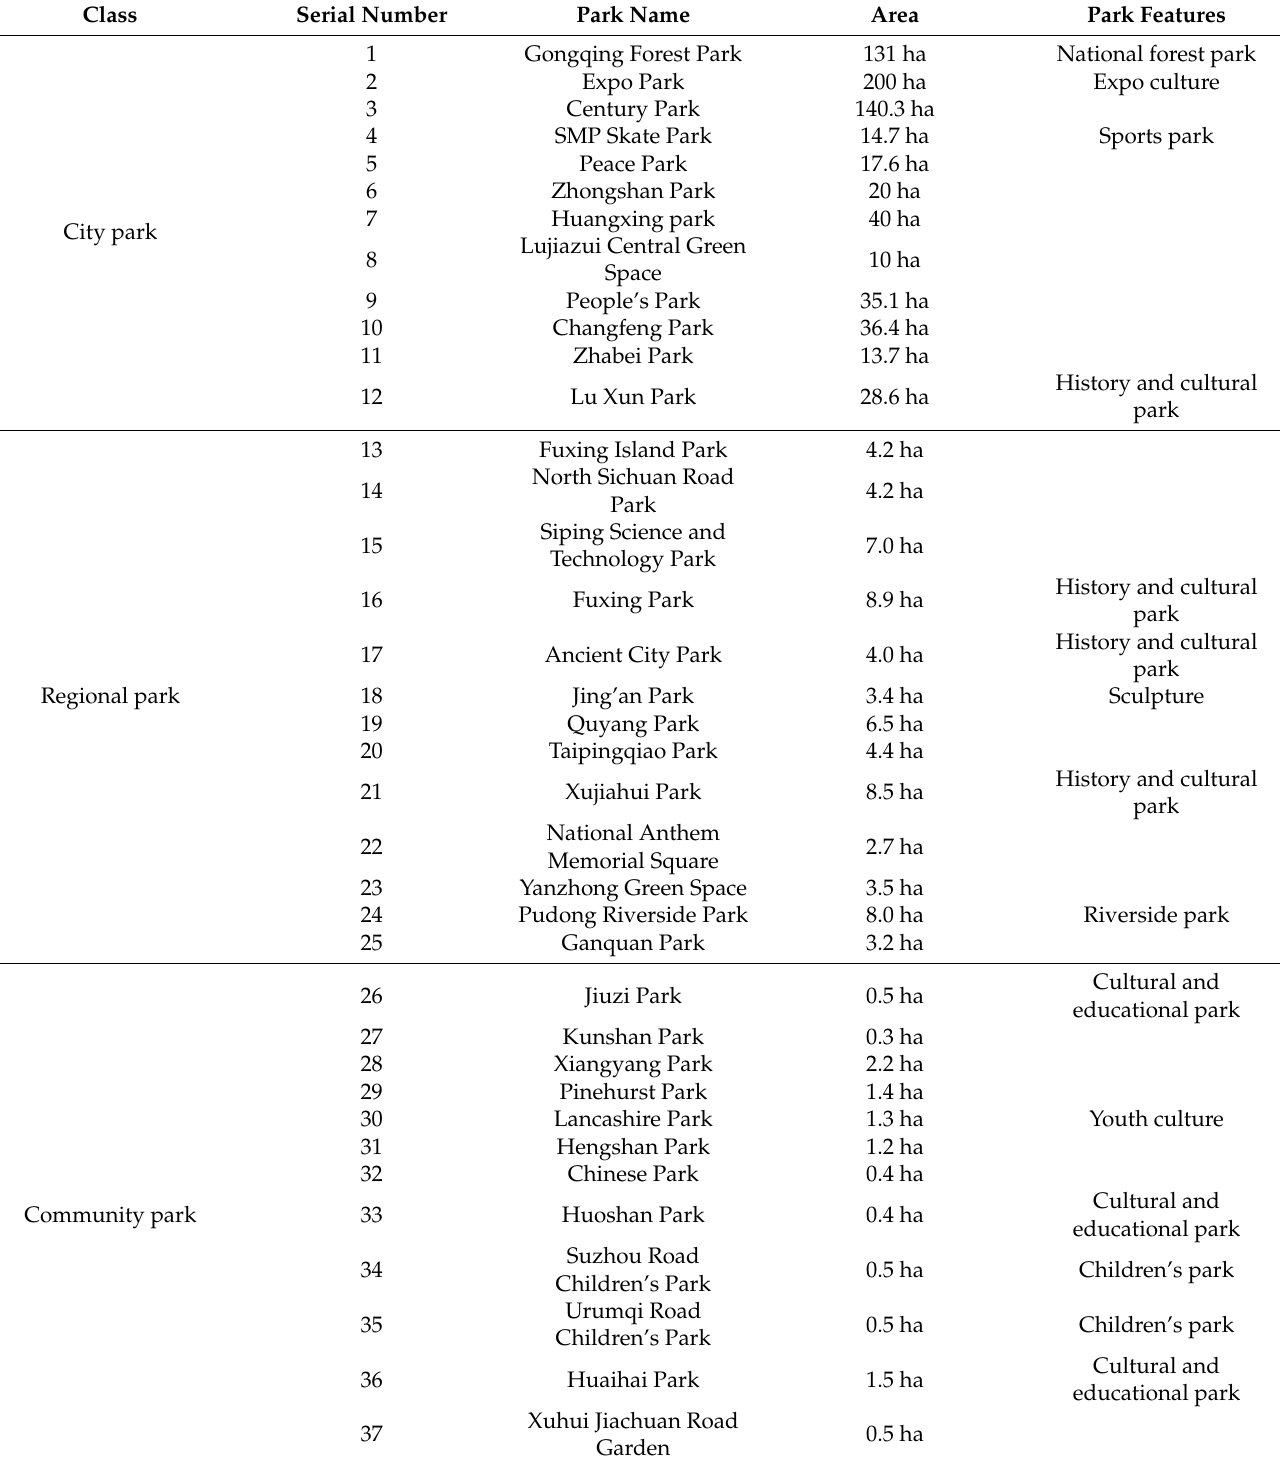
Table 1. The Urban parks information